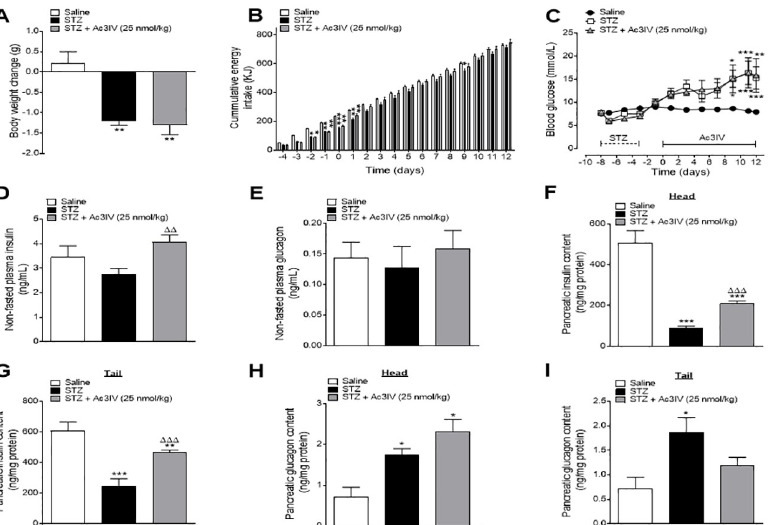
Fig 6. Effects of Ac3IV treatment on body weight, blood glucose, plasma insulin and pancreatic hormone content in STZ-diabetic GluCreERT2;Rosa26-eYFP mice. Body weight change (A), cumulative energy intake (B) and circulating blood glucose (C) were measured during twice daily treatment with saline (0.9% NaCl) vehicle or Ac3IV (25 nmol/kg bw, i.p.) for 12 days in STZ-diabetic GluCreERT2;Rosa26-eYFP transgenic mice. Plasma insulin (D) and glucagon (E), as well as pancreatic hormone content in the head (F,H) and tail (G,I) of the pancreas were measured on day 12. Solid lines parallel to x-axis indicate peptide treatment while dashed lines represent days of diabetes induction by STZ (C). Values are mean ± SEM for n = 6 mice. � p < 0.05, �� p < 0.01, ��� p < 0.001 compared to saline vehicle. ΔΔ p < 0.01 and ΔΔΔ p < 0.001 compared to STZ-diabetic